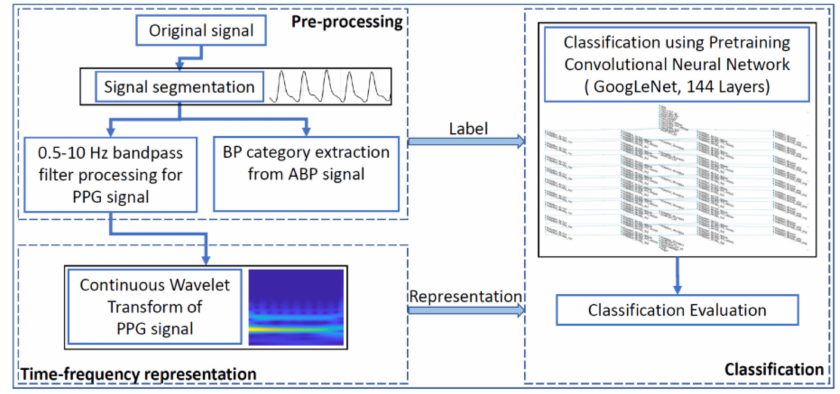
Figure 3. Flowchart of the